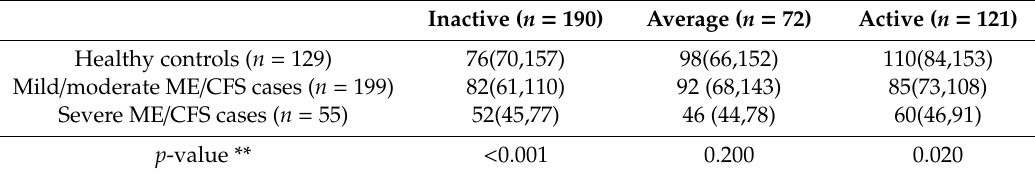
Table 5. Median total CK (IQR) according to reported activity levels